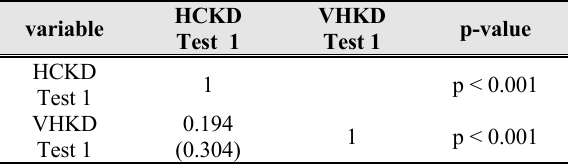
Correlation between HCKD and VHKD (Test 1) variable